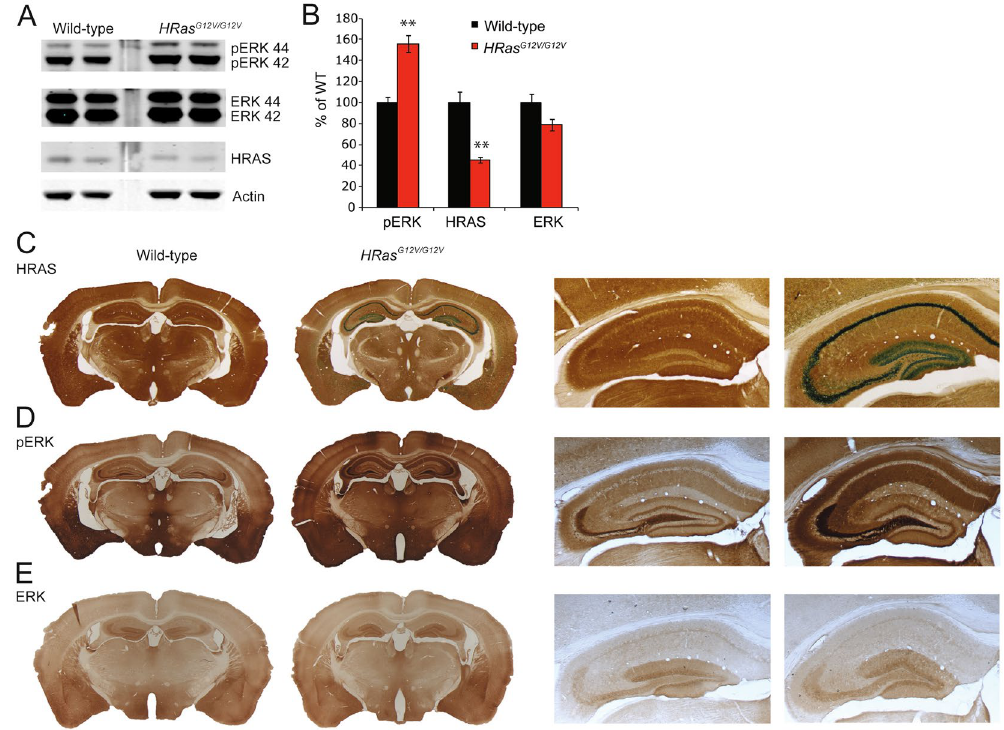
Figure 1. Hyperactivity of RAS-ERK signaling in HRas G12V/G12V mice. ( A ) Western blots of hippocampal lysates taken from wild-type and HRas G12V/G12V mice using antibodies for HRAS, pERK 42/44 (pERK), ERK 42/44 (ERK) and actin. ( B ) Quantification of Western blots showing a significant increase in pERK ( t 8 = − 5.92, P < 0.01) and a significant decrease in expression of HRAS protein in HRas G12V/G12V mice compared to their wild-type littermates ( t 8 = 5.34, P < 0.01). Data are presented as mean ± SEM of percentage of WT level set as 100% from 5 mice per genotype (n = 5/genotype). Statistical test: unpaired two-tailed t-test, * P < 0.05, ** P < 0.01. ( C ) Visualisation of β -galactosidase activity of the IRES– β -geo cassette integrated into the mutated HRAS gene (LacZ; blue) combined with an HRAS staining (DAB; brown) indicating successful recombination and expression of HRAS G12V , however lower amounts of HRAS protein are seen in HRas G12V/G12V mice compared to WT littermates. Right panel: Zoomed-in image of hippocampus. ( D,E ) DAB staining using pERK 42/44 and ERK 42/44 antibodies revealed increased levels of ERK phosphorylation in HRas G12V/G12V mouse brain slices compared to WT ( D ), but no difference in the level of expression and distribution of total ERK between genotypes ( E